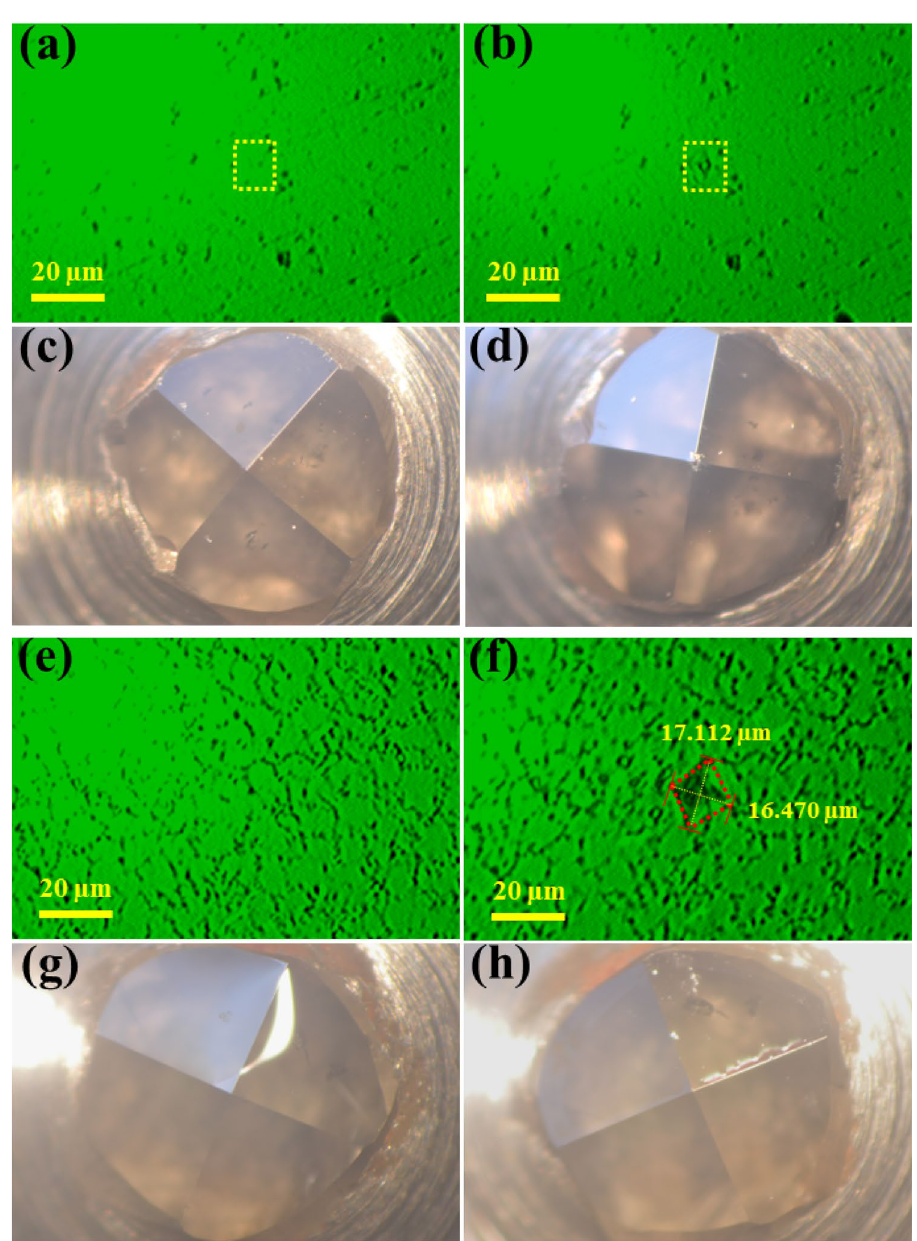
Figure 7. Hardness. Optical picture of the polished CFPDC and commercial PDC sample surfaces before ( a , e ) and after ( b , f ) hardness test with a load of 9.8 N and dwelling time of 15 s, respectively. Photographs of Vickers indenter tip before ( c , g ) and after ( d , h ) hardness test of CFPDC and commercial PDC samples under a load of 9.8 N and dwelling time of 15 s, respectively. We could draw a conclusion that the hardness of the